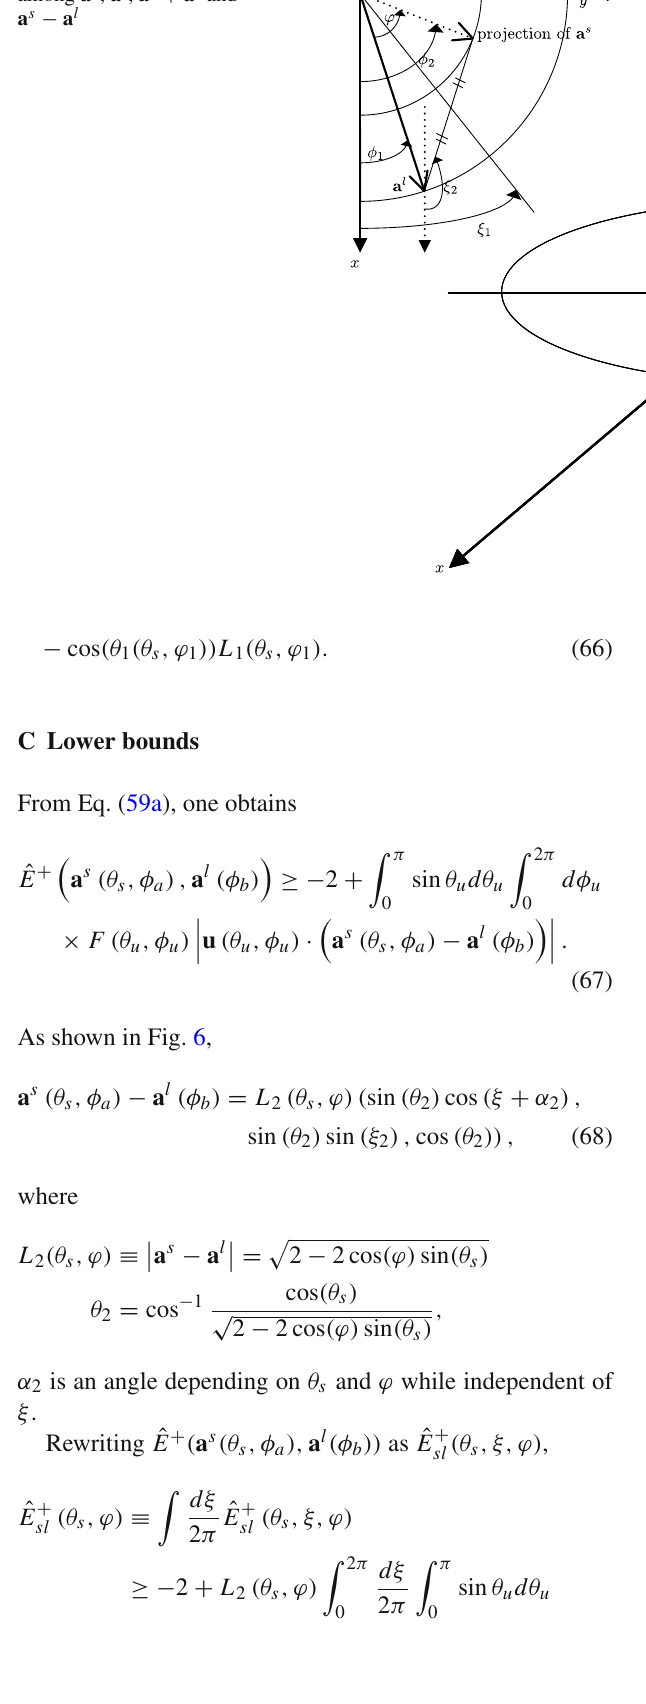
Fig. 6 Geometric relations among a s , a l , a s + a l